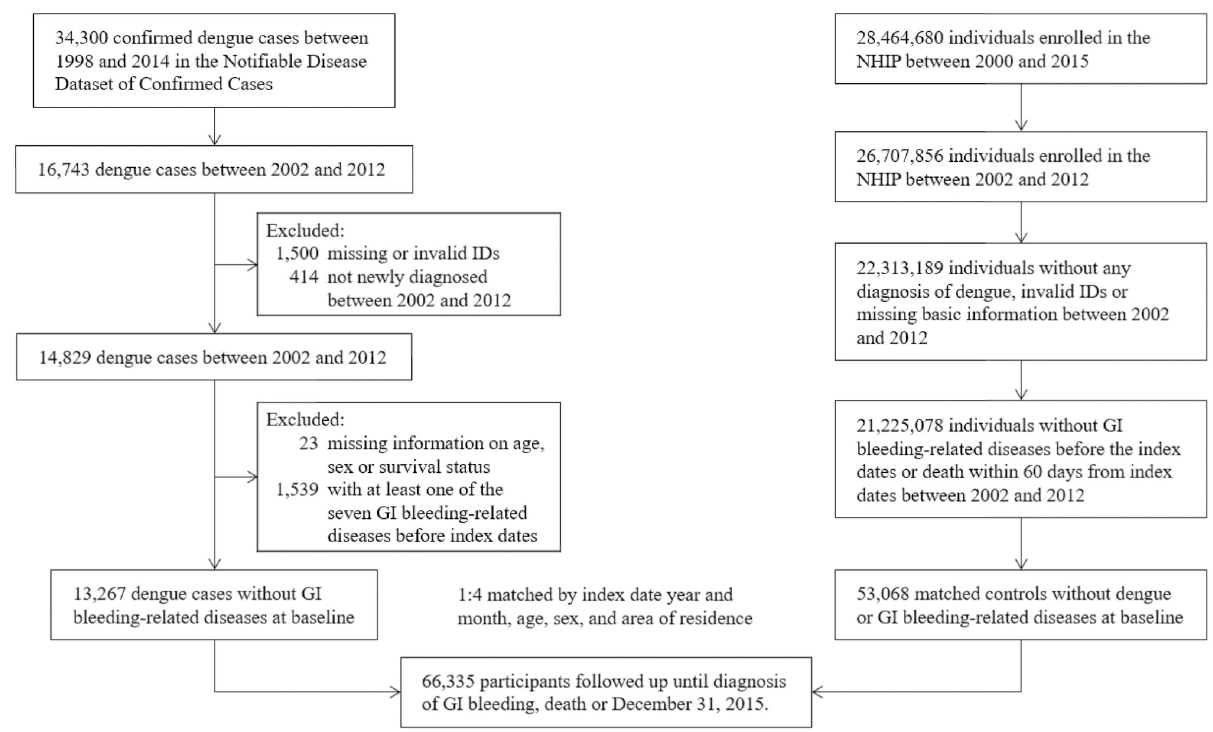
Fig 1. Flow diagram of the selection of the study